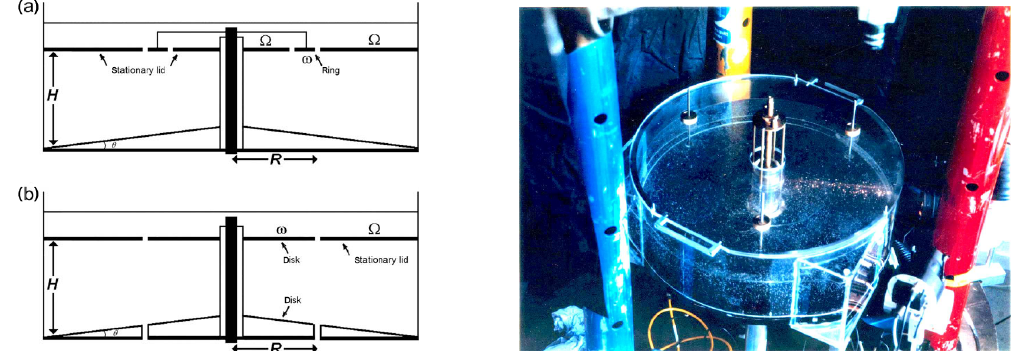
Figure 2. Schematic cross sections of two versions of the apparatus for producing and studying barotropic instabilities in a cylindrical tank of fluid on a rotating table at angular velocity (cid:127) . In (a) a differentially rotating, axisymmetric ring is used to drive a barotropic jet at relative angular velocity ω at radius R , while in (b) a pair of differentially rotating disks, centred on the rotation axis, generate a detached Stewartson shear layer, also at radius R . In these cases, a topographic β effect is also included by the use of a conically sloping bottom with slope angle θ . (c) Photograph of the detached shear layer apparatus as used by Früh and Read (1999a) for investigating fully developed barotropic instabilities.